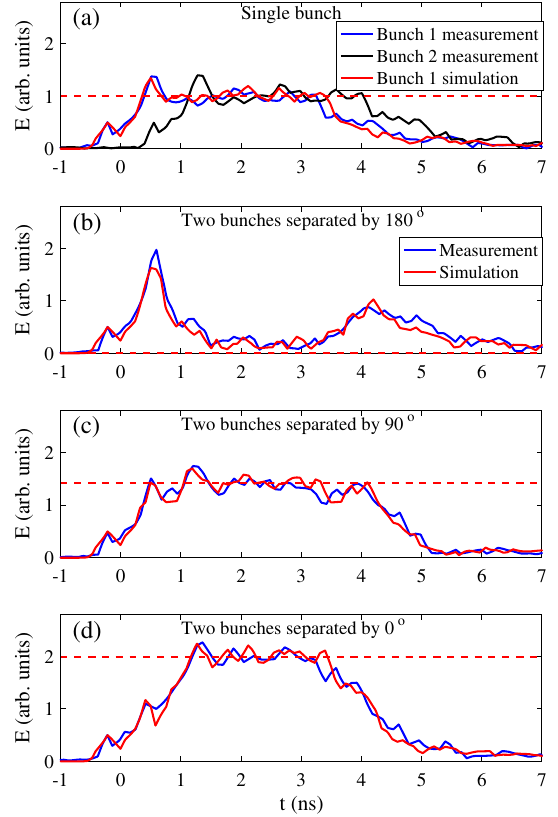
FIG. 14. Comparison between rf pulses measured by the pickup and the output port signal from the CST Particle Studio simulation when tuning the first stage. The same amplitude normalization factor has been applied to all signals to show the relative amplitude change. The red dashed lines in (a – d) denote 1, 2 × cos ð 180 ° = 2 Þ , 2 × cos ð 90 ° = 2 Þ , and 2 × cos ð 0 ° = 2 Þ , respec- tively. The time, t ¼ 0 , is set to be the same as that in Fig. 6.